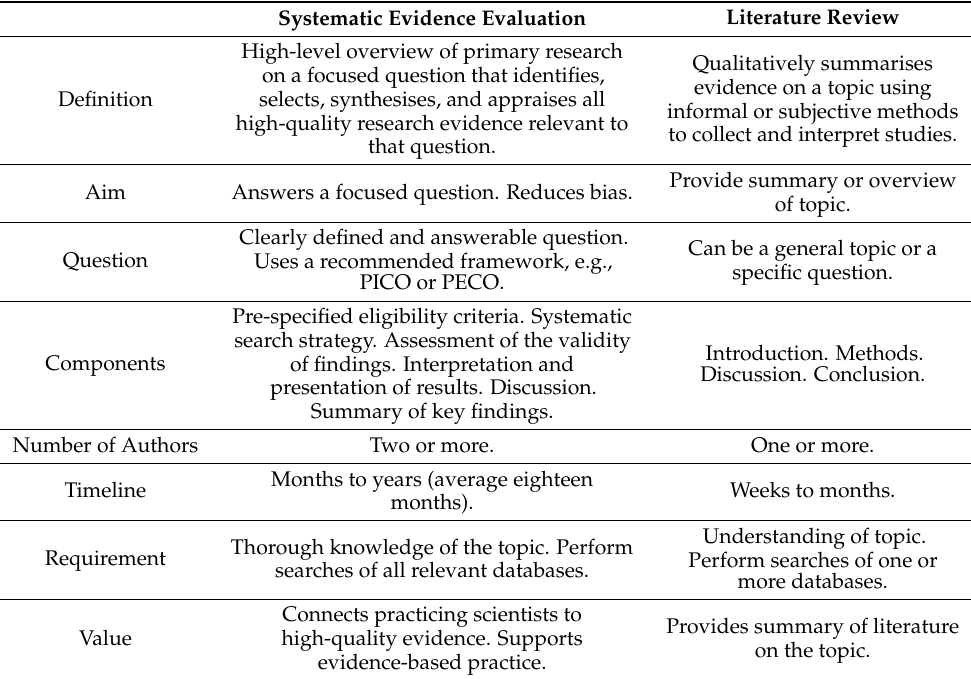
Table 1. Main differences between systematic evidence evaluations and traditional literature